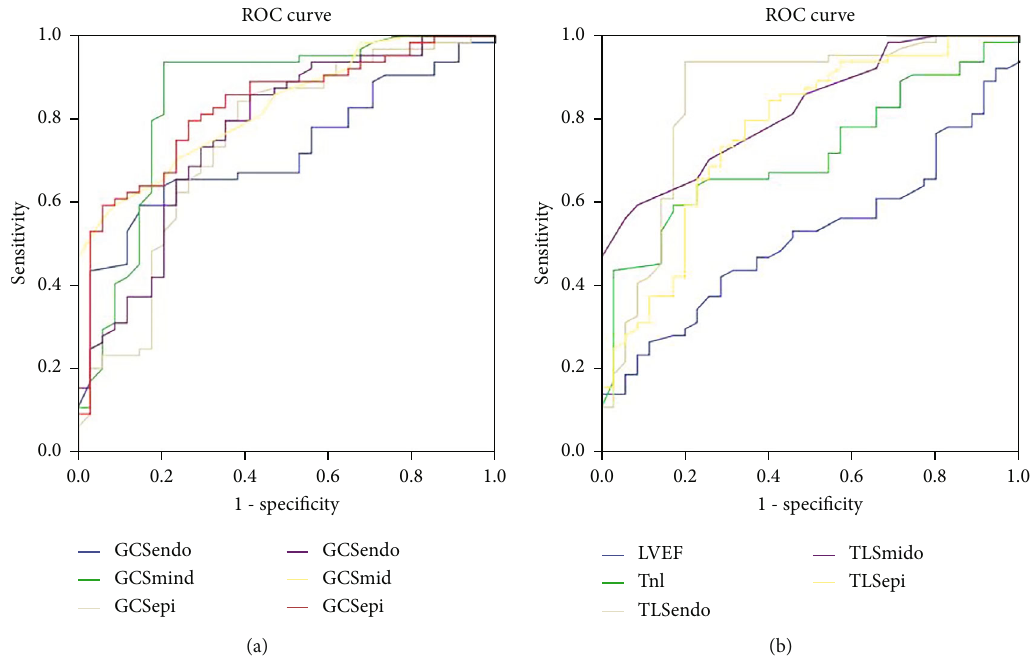
Figure 1: The ROC curve was used to evaluate the ability of LVEF, TnI, and strain parameters in diagnosing patients with signi fi cant CAD. Table 5: Intra- and interobserver variability. Parameters Intraobserver